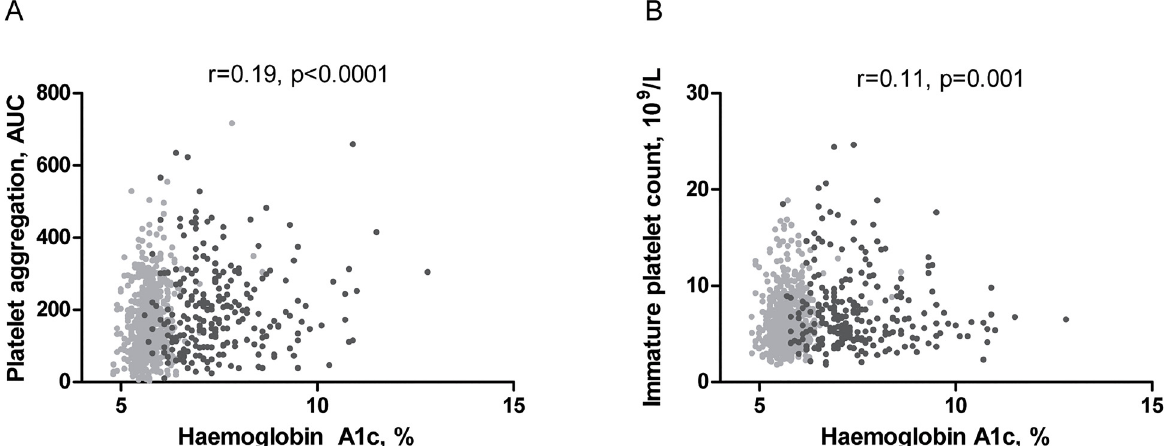
Fig 2. Correlation between haemoglobin A1c and platelet aggregation and platelet turnover. Correlation between HbA1c and A) platelet aggregation induced by arachidonic acid 1.0 mM and B) immature platelet count in patients with coronary artery disease (n = 861). Patients without diabetes (no antidiabetic drugs, n = 620) are marked with light grey and patients with type 2 diabetes (on antidiabetic drugs, n = 241) are marked in dark grey.